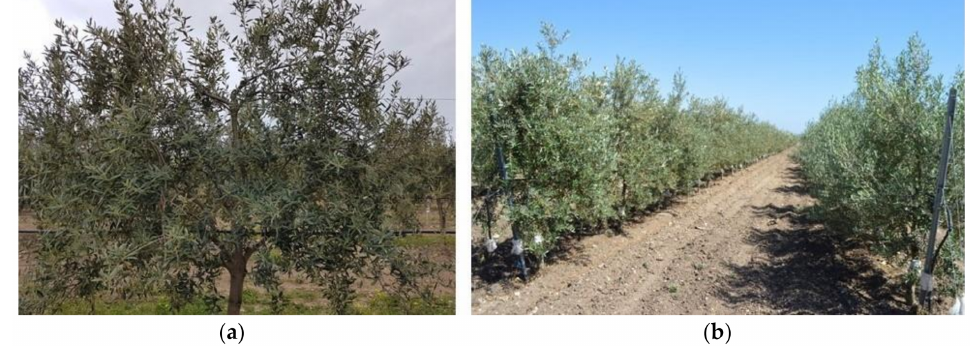
Figure 2. Example of high-density “pedestrian olive orchard” in southern Sicily: ( a ) ‘Calatina’ olive tree trained to “free palmette”; ( b ) continuous walls of “Calatina” trees trained to “free